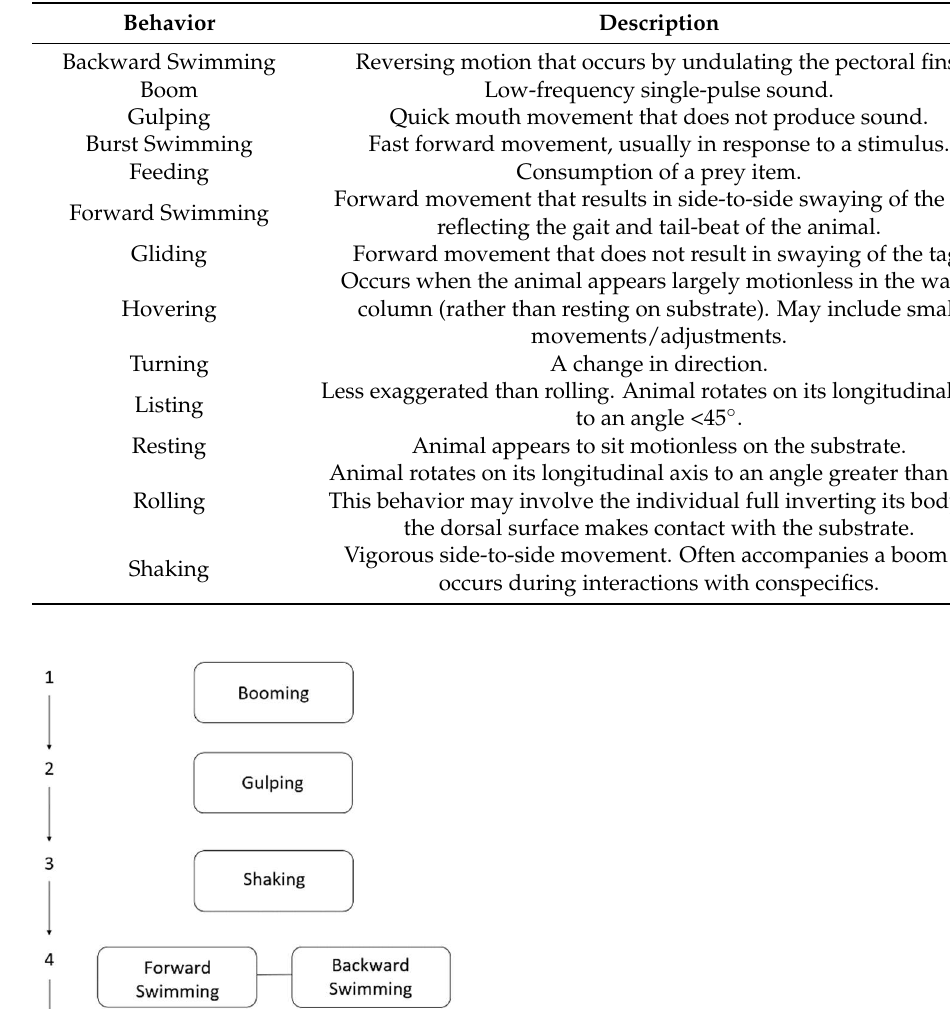
Table 2. Description of behavioral classes used to label the inertial measurement unit data. See Supplementary Materials Video S1 for examples of each behavior.